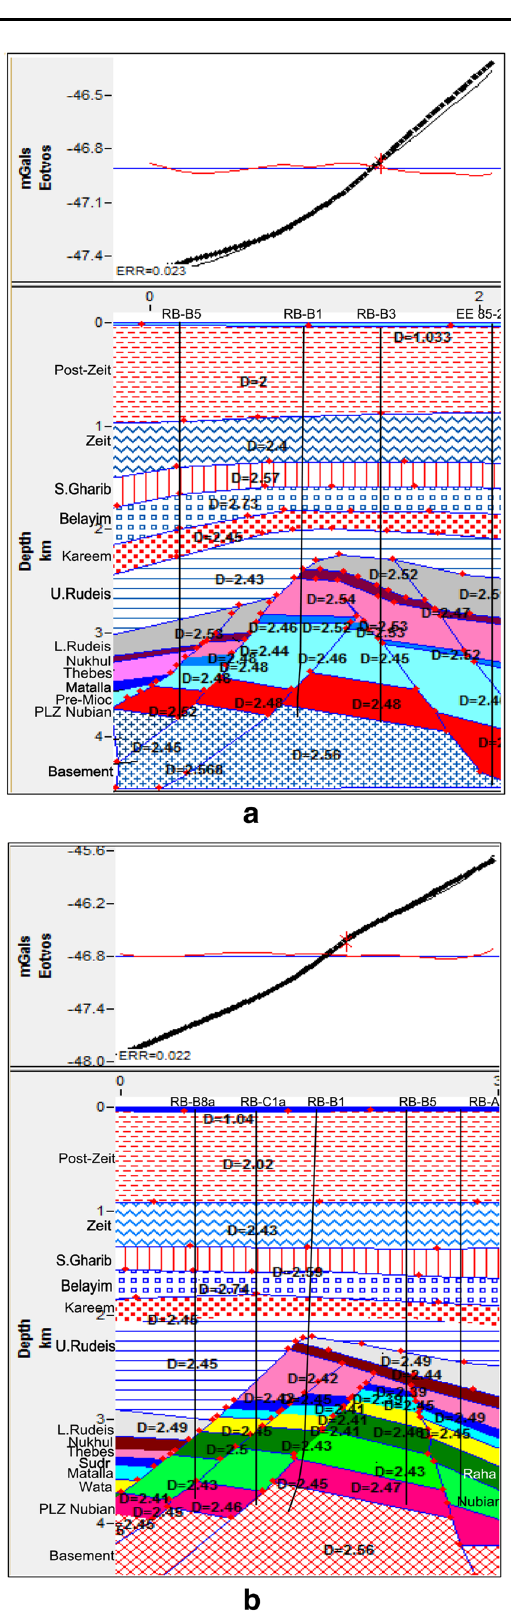
Fig. 9 a 2.5 Density model along prof-1 in the NW–SE direction.